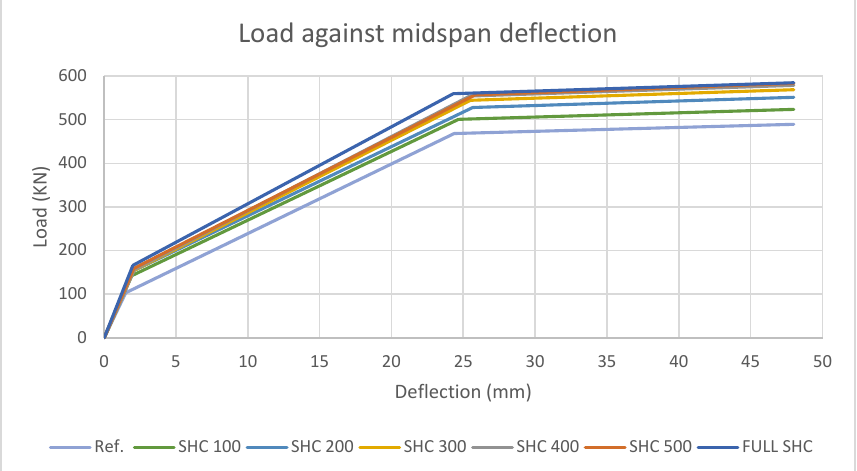
Figure 4. Load against displacement curves of beam models.